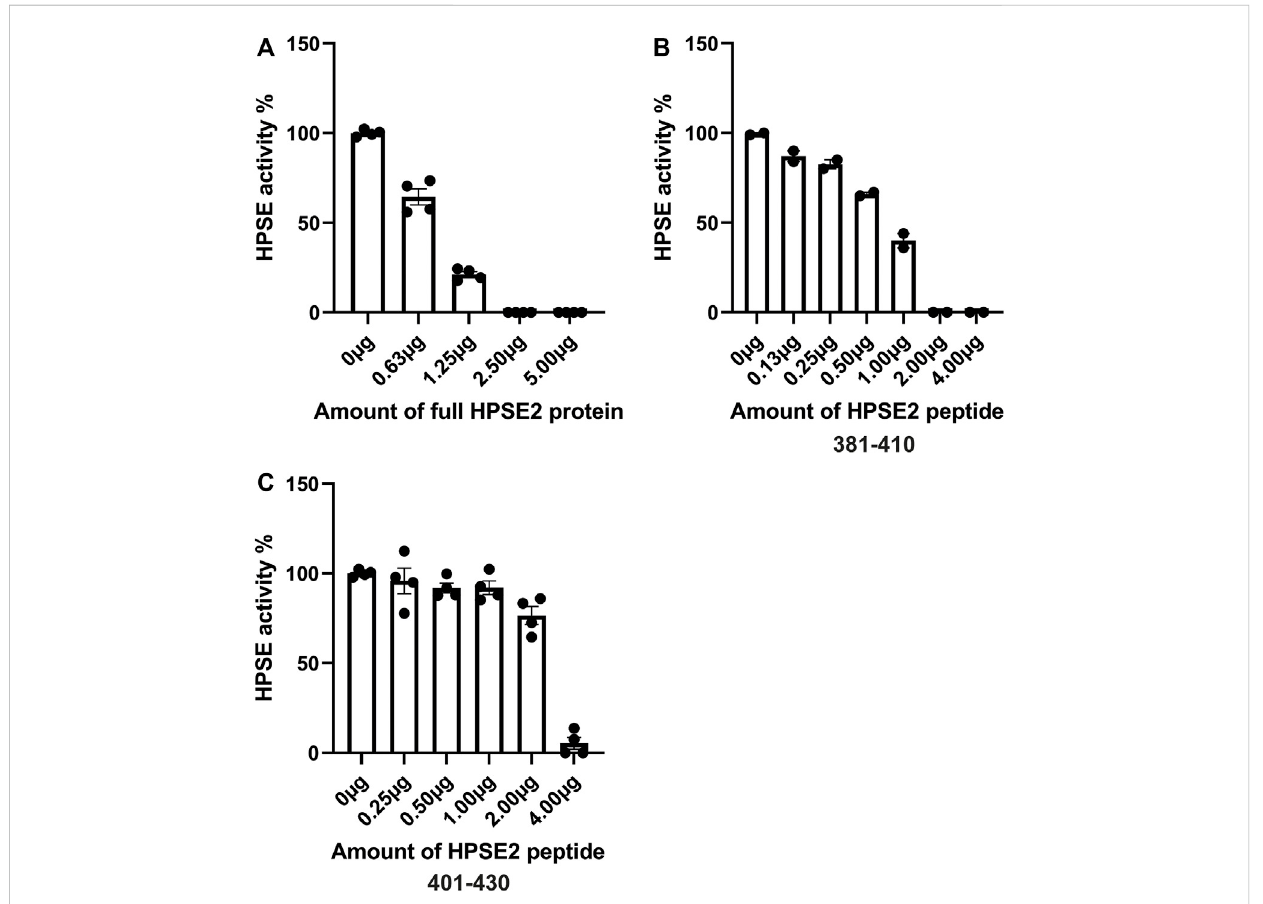
FIGURE 4 Inhibition of HPSE1 activity is dose-dependently achieved by HPSE2 protein and HPSE2 peptides. Dose response inhibition of recombinant human HPSE1 with the full HPSE2 protein (A) and HPSE2 peptides (B,C) . HPSE2, heparanase-2; HPSE1,